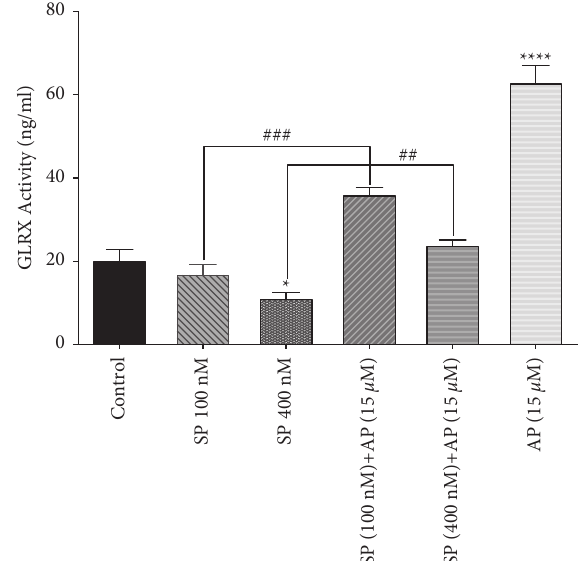
Figure 4: The effects of SP and aprepitant on glutaredoxin activity in U87 glioblastoma cells. The results demonstrate that gluta- redoxin activity is significantly increased in cells treated with aprepitant (15 μ M) with or without pretreatment with SP (100 and 400nM) as compared to the untreated control cells. The activity of glutaredoxin is indicated as